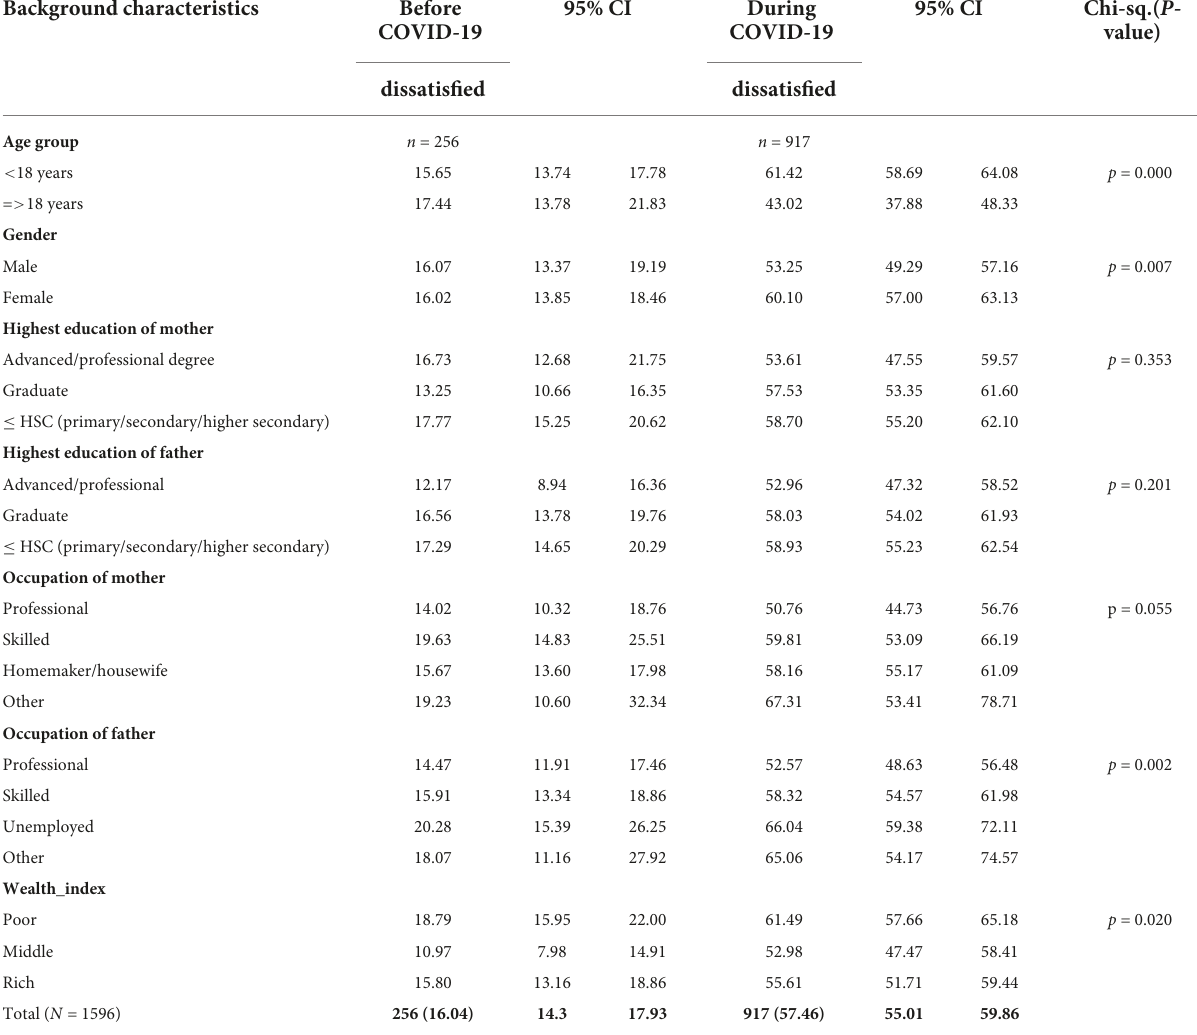
TABLE 2 Percentage of respondents who were dissatisfied with their general life, before and during COVID-19 with Chi-Square test of association. Background characteristics Before 95% CI During 95% CI Chi-sq.( P - COVID-19 COVID-19